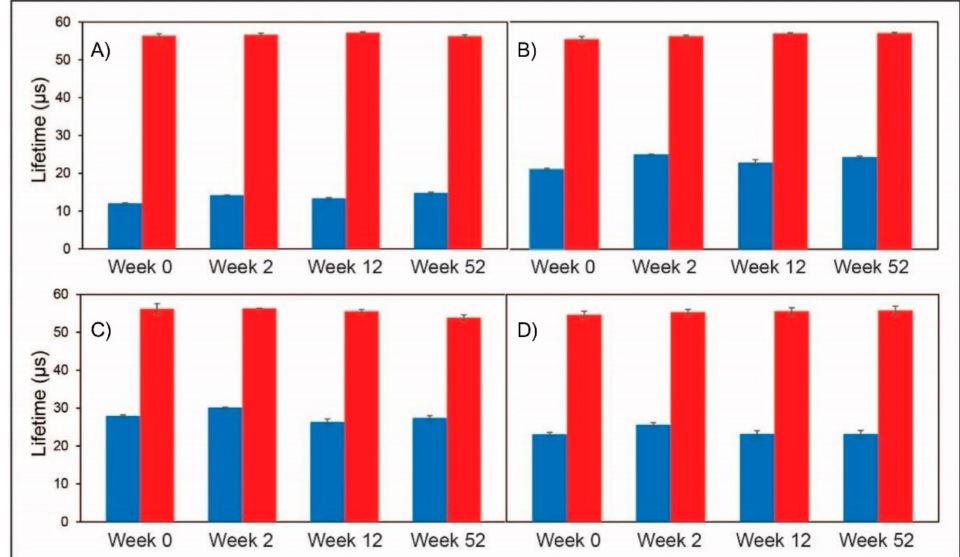
Figure 6. Averaged lifetimes at 21 kPa O 2 (blue) and 0 kPa O 2 (red) for the: Type 1 ( A ); Type 2 ( B ); Type 3 ( C ); and Type 4 ( D ) sensors over the 52 weeks of storage